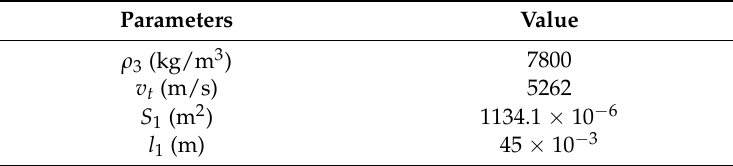
Table 3. The material parameters of the steel used in the back mass.